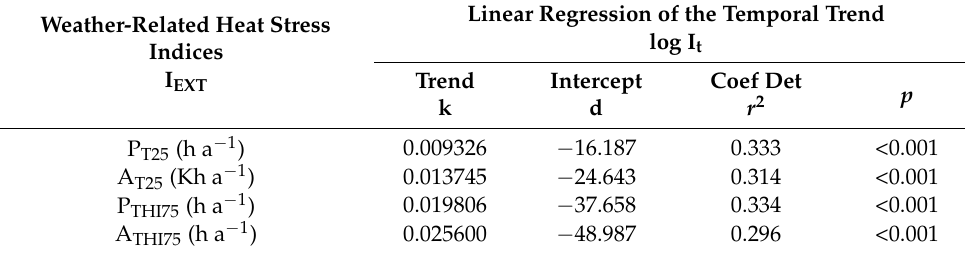
Table 4. The results of all four weather-related HS indices of the vector I EXT show a high significance with p < 0.001 and a coefficient of determination r 2 between 30% and 33%. Table 4. Temporal trend of the weather-related heat stress indices log I t = kt + d, calculated by the logarithmically transformed heat stress indices log I EXT with the slope k, the intercept d, the coefficient of determination r 2 , and the p value.